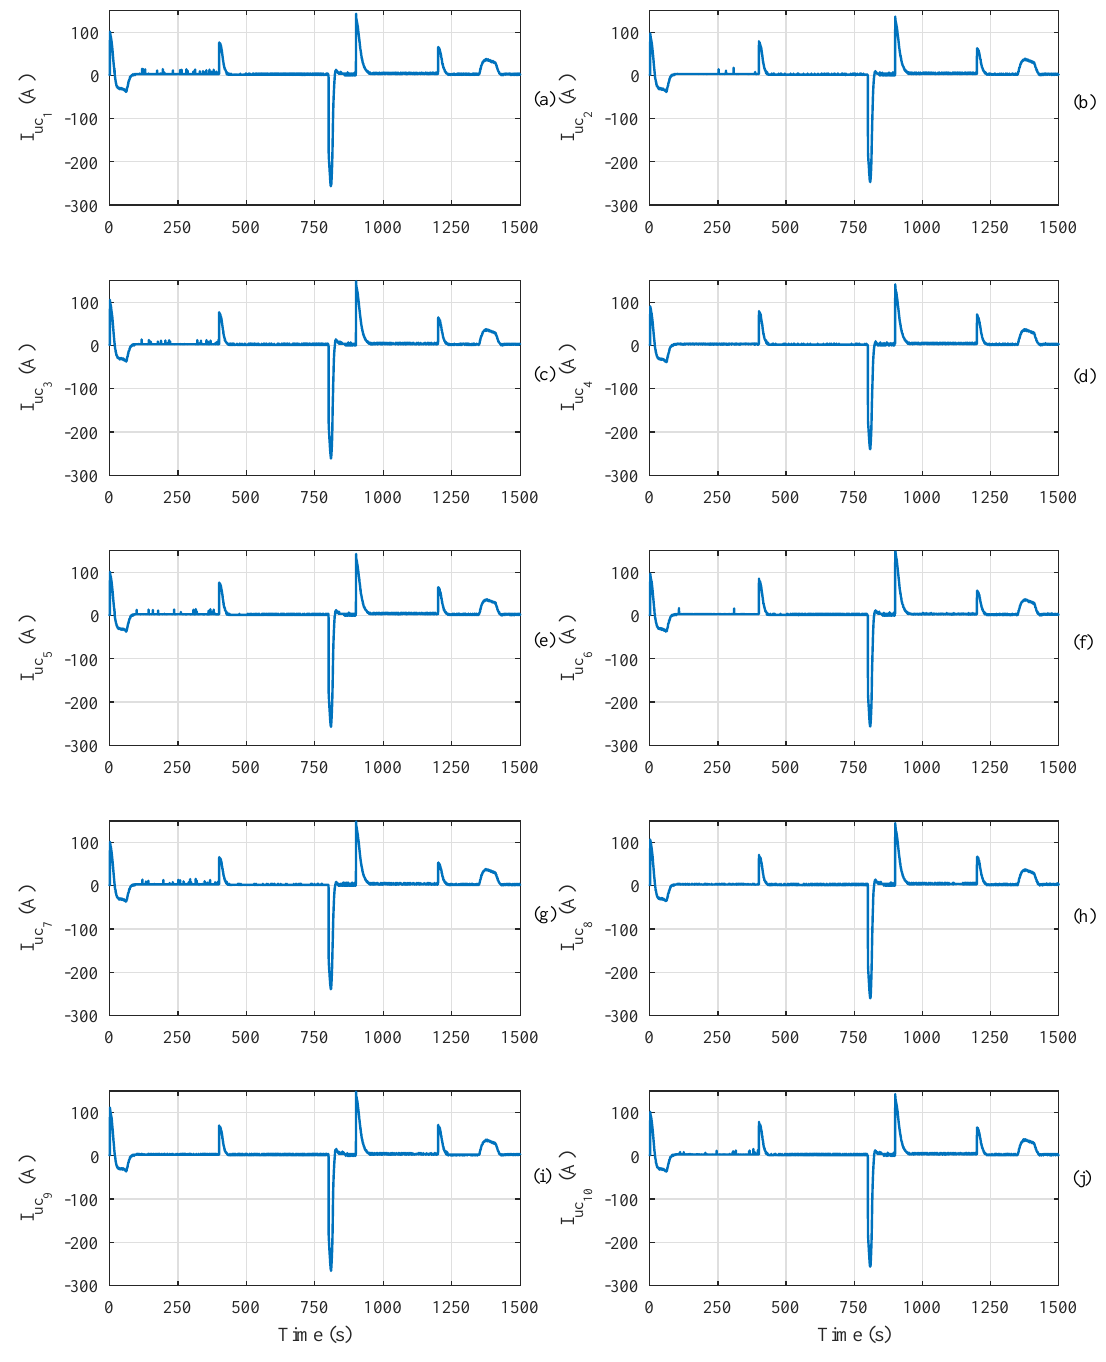
Figure 19. Currents through the ultracapacitors of the 10 hybrid energy storage systems